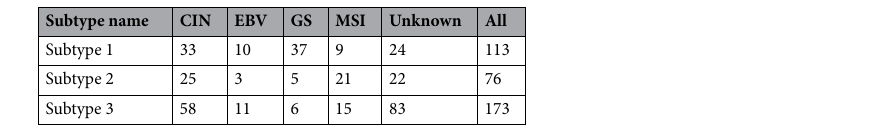
Table 1. The relationship between the existing four molecular subtypes and our identified